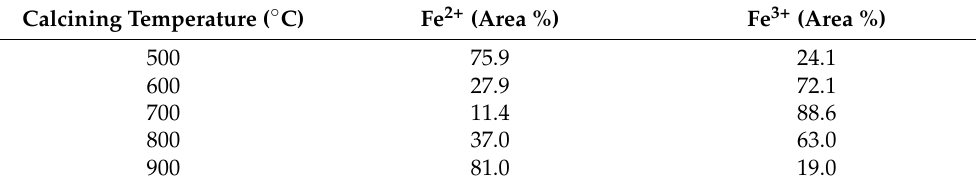
Figure 11. XPS spectra of RhCrO x /Pr-LaFeO 3 photocatalysts after calcination at different temperatures: ( a ) Pr 3d, ( b ) La 3d, ( c ) Fe 2p, ( d ) O 1s, ( e ) Rh 3d, and ( f ) Cr 2p, and the green, pink and blue fitted curves for different metal. Table 2. Area ratios of Fe 2+ and Fe 3+ in the XPS spectra of Pr-LaFeO 3 photocatalysts treated at different calcination temperatures.